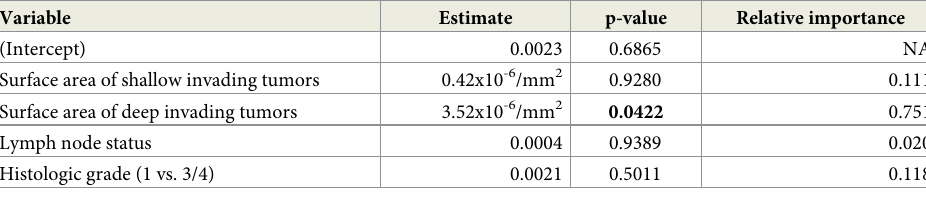
Table 3. Analytical model for colorectal